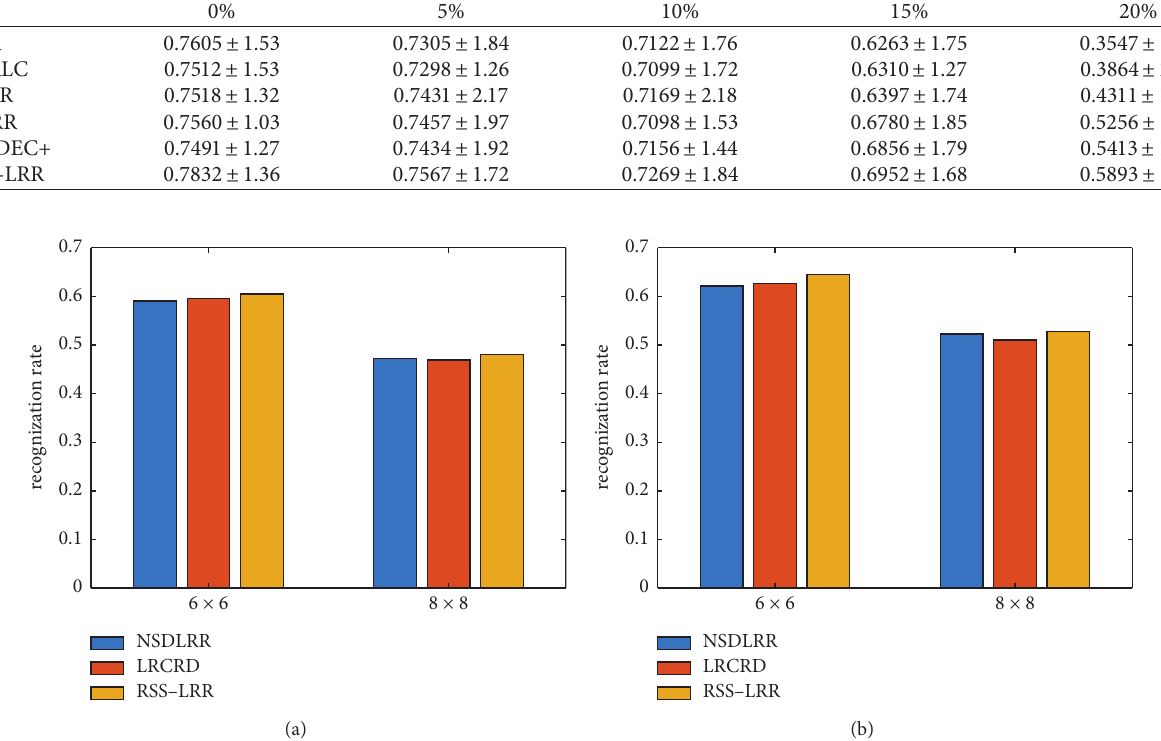
Figure 7: Classification results concerning the accuracy of different SOTA methods on (a) COIL100 and (b) LFW datasets under various block occlusion levels.